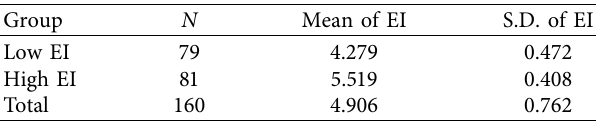
Table 2: Two groups by level of